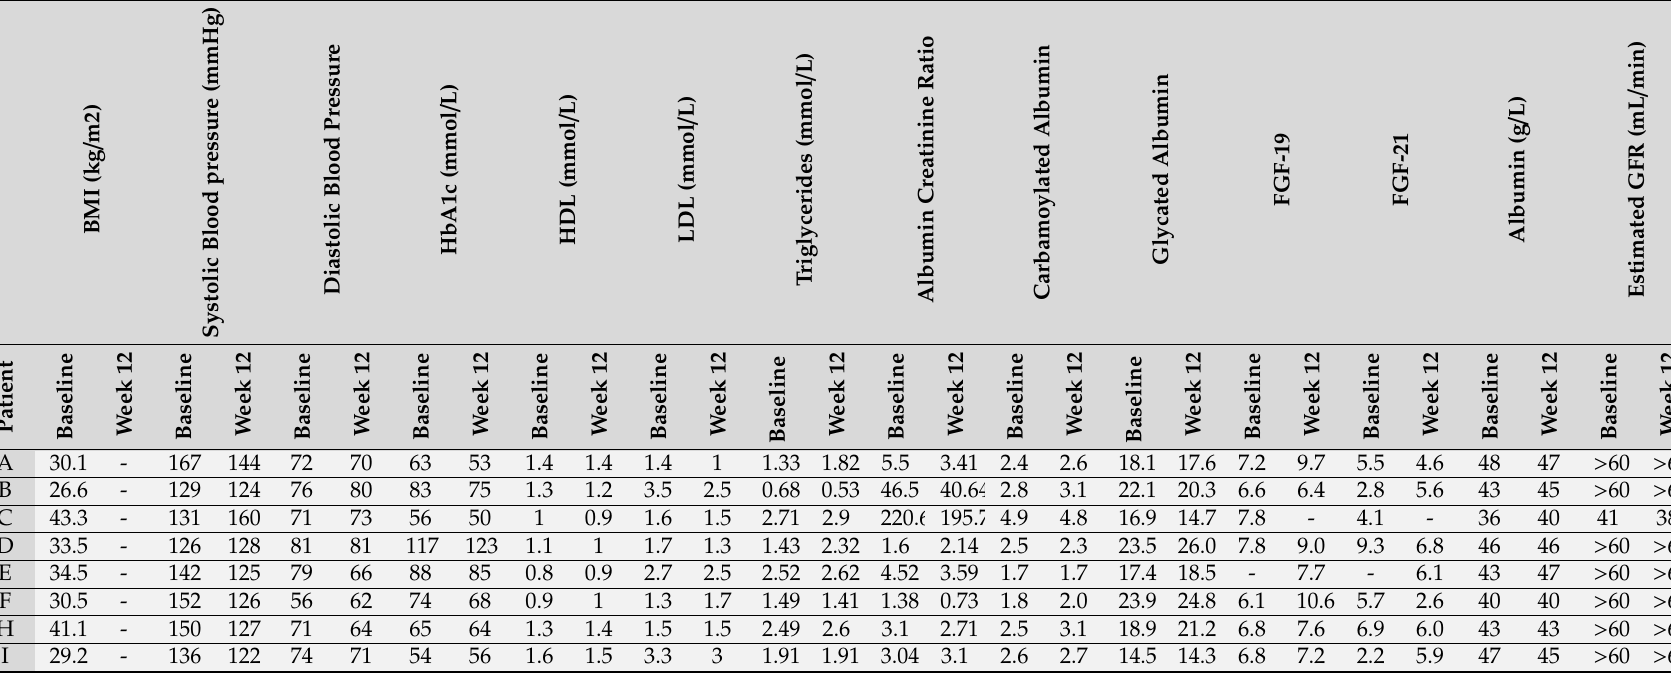
Table 5. Individual systemic parameters for all patients that completed the study ( n = 8) at baseline and at week